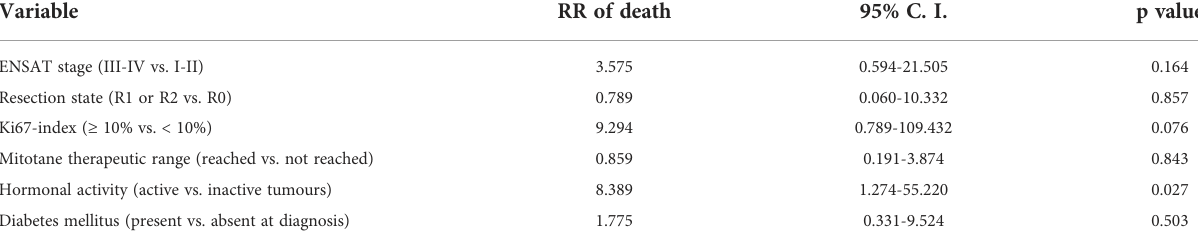
TABLE 3 Multivariate Cox regression analysis of clinical parameters associated with mortality in univariate analysis. Variable 95% C.